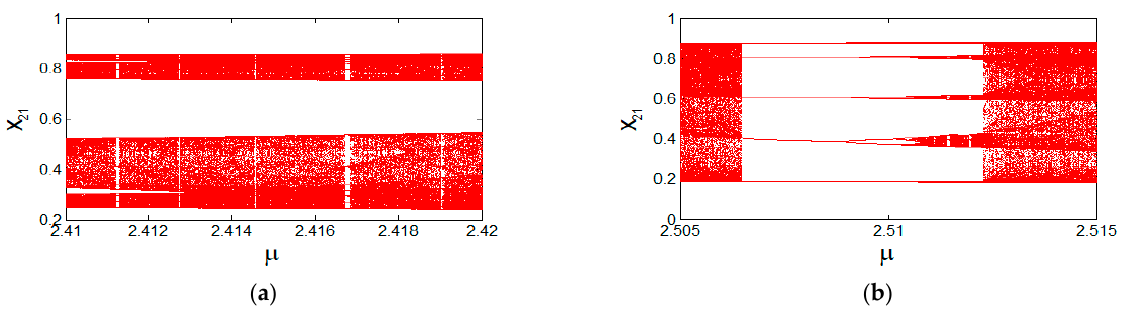
Figure 4. The bifurcation diagram of model 2 for µ : ( a ) µ ∈ [ 2.41,2.42 ] ; ( b ) µ ∈ [ 2.505,2.515 ] .